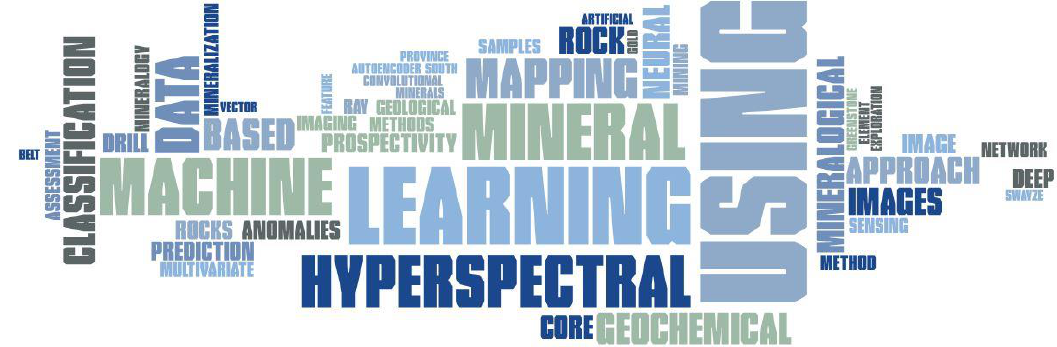
Figure 6. Word frequency map of the title of the reviewed records.